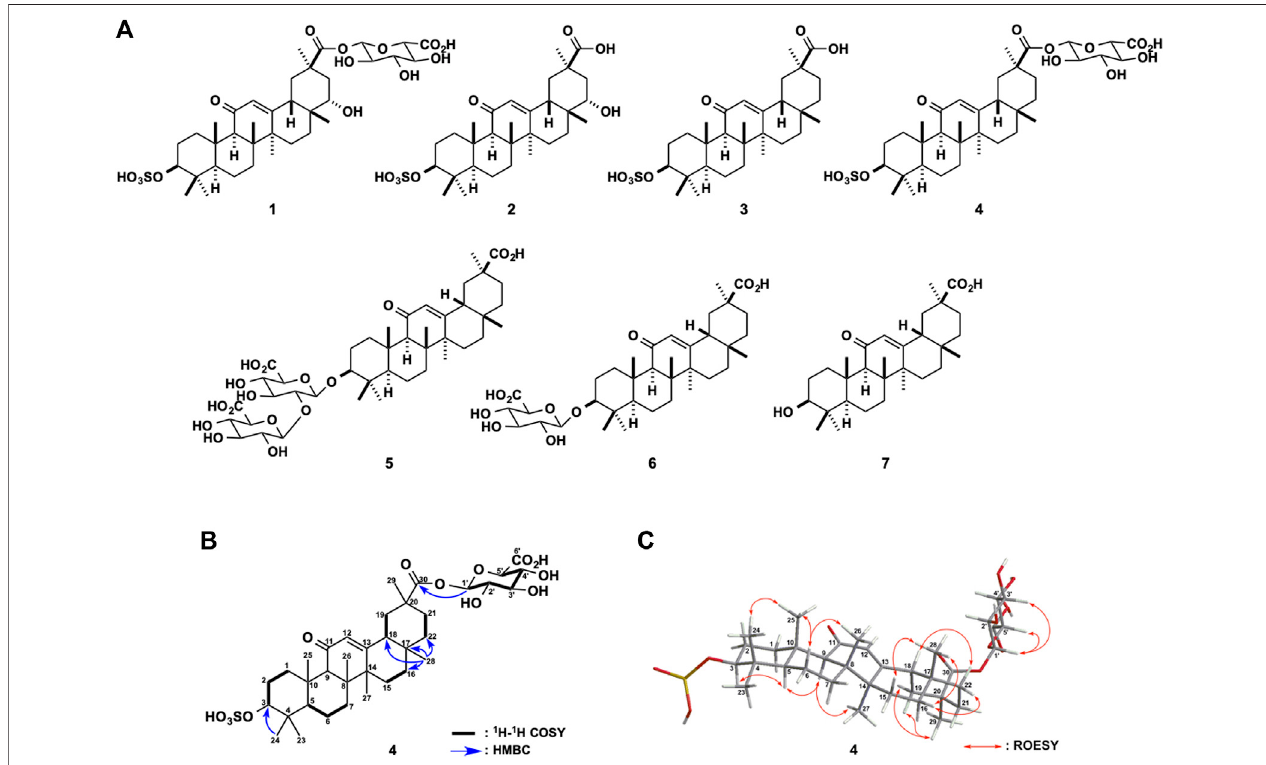
FIGURE1|(A) Chemicalstructuresofglycyrrhizin(GL, 5 )anditsmetabolites( 1 − 4 ),18 β -glycyrrhetyl-3- O -glucuronide(3MGA, 6 ),andglycyrrhetinicacid(GA, 7 ) (B) Key two-dimensional (2D) nuclear magnetic resonance (NMR) correlations for 4 (C) Selected rotating frame overhause effect spectroscopy (ROESY) correlations and relative stereochemistry of 4